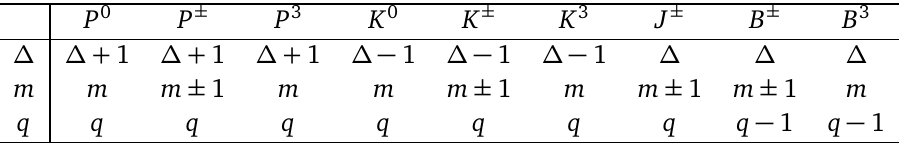
Table 3: The way that symmetry generators change the quantum